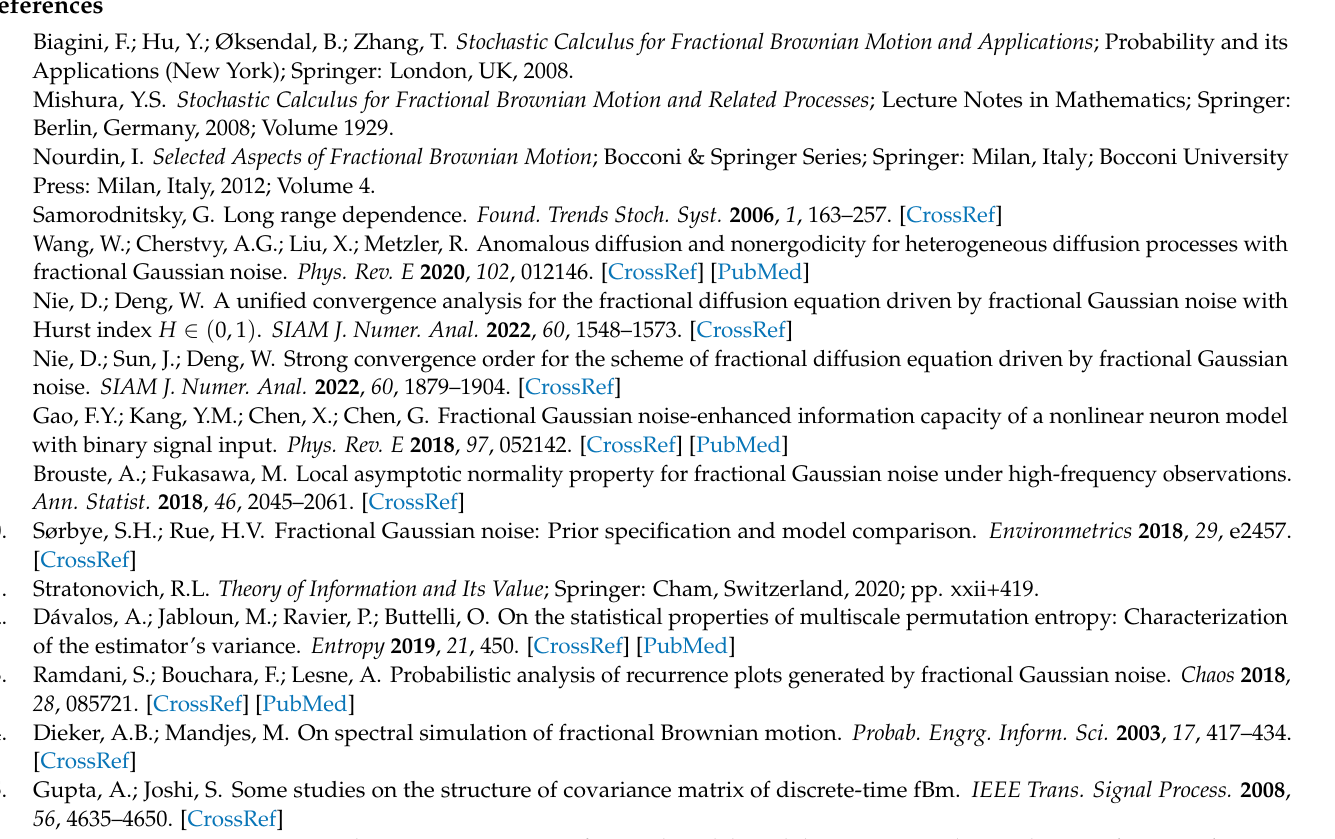
, Γ 3 , Γ 4 , and Γ 5 5 5 5